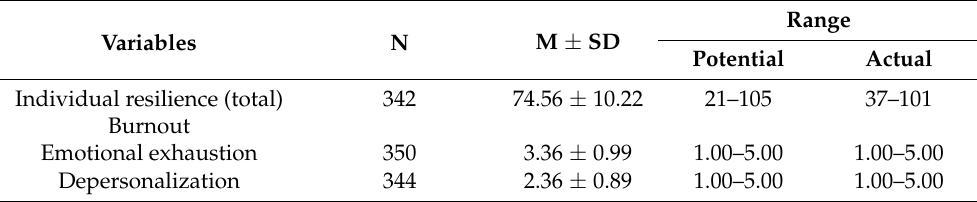
Table 2. Scores for individual resilience and burnout.